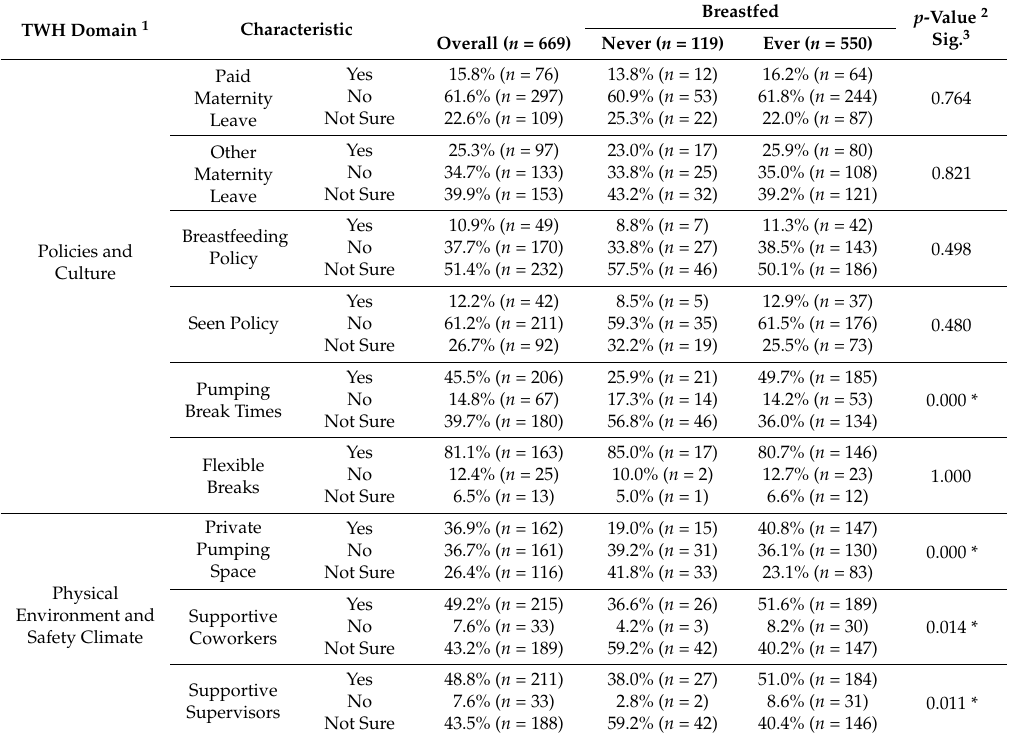
Table 2. Maternal Workplace Characteristics by Breastfeeding Initiation (Never versus